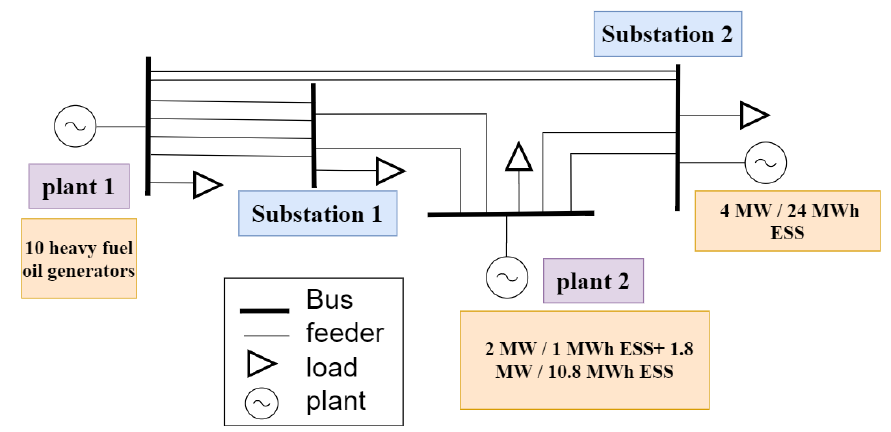
Figure 3. System diagram.